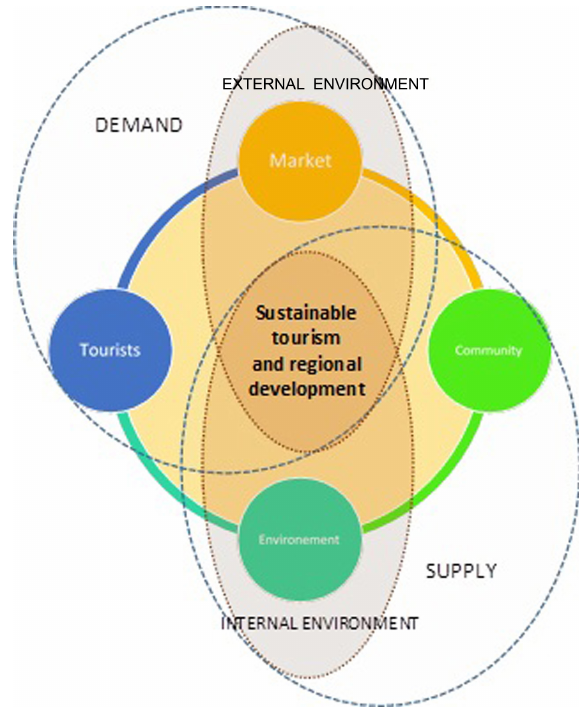
Fig. 4. Participatory operational framework for sustainable tourism and regional